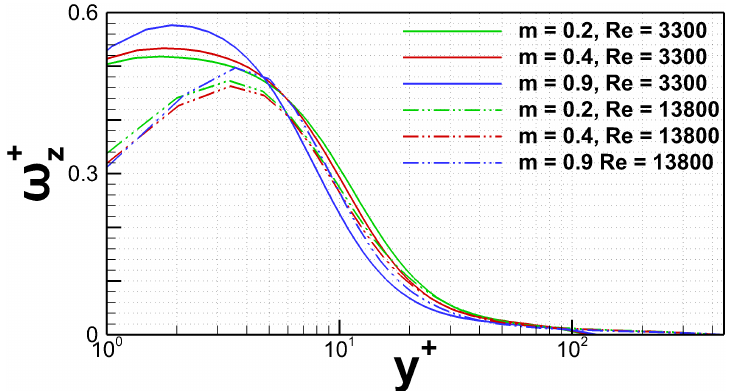
Figure 4. Normalized spanwise micropolar velocity ( ω + z ) for: Re = 3300 and 5600 of the present: m = 0.2,0.4 and 0.9